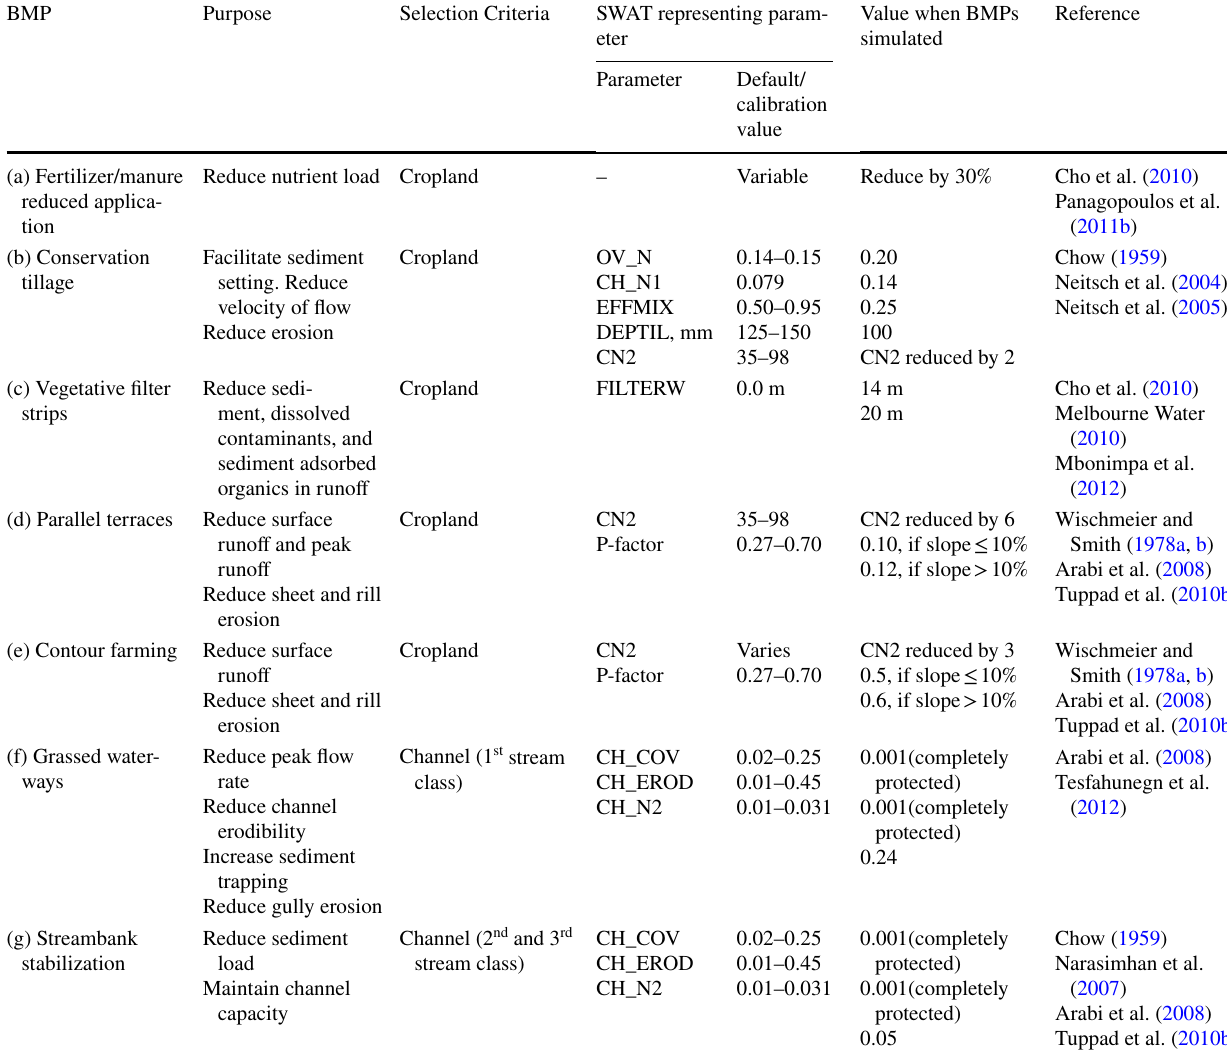
Table 1 Interpretation of different BMPs in the MYS management of water quality